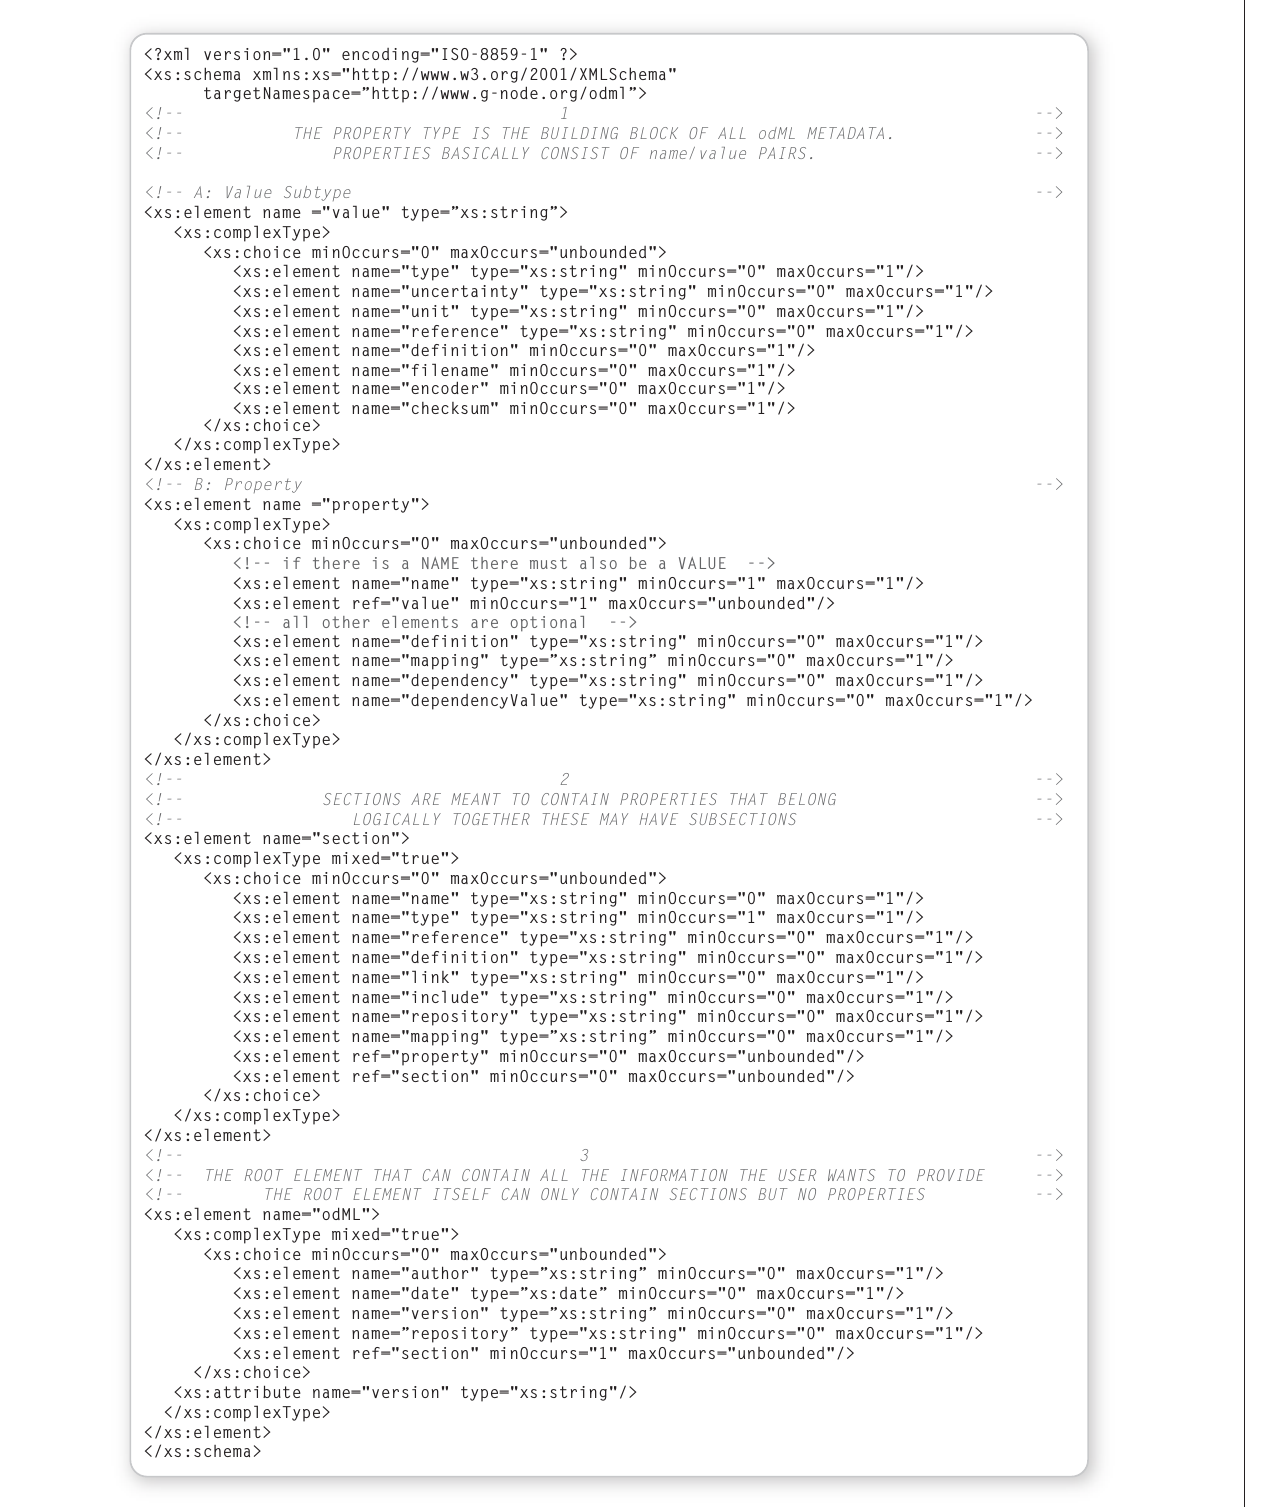
“section,” “name,” etc.) have to be written as defined in this schema. In our schema all tags use the “lower camelCase” or “compoundNames” which is lower case except for the first letter of subsequent words in